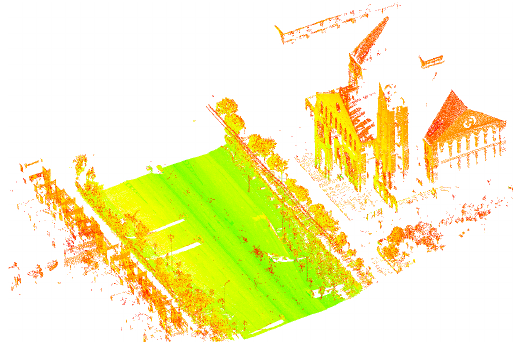
Figure 2. The raw point cloud data contains massive amounts of irrelevant